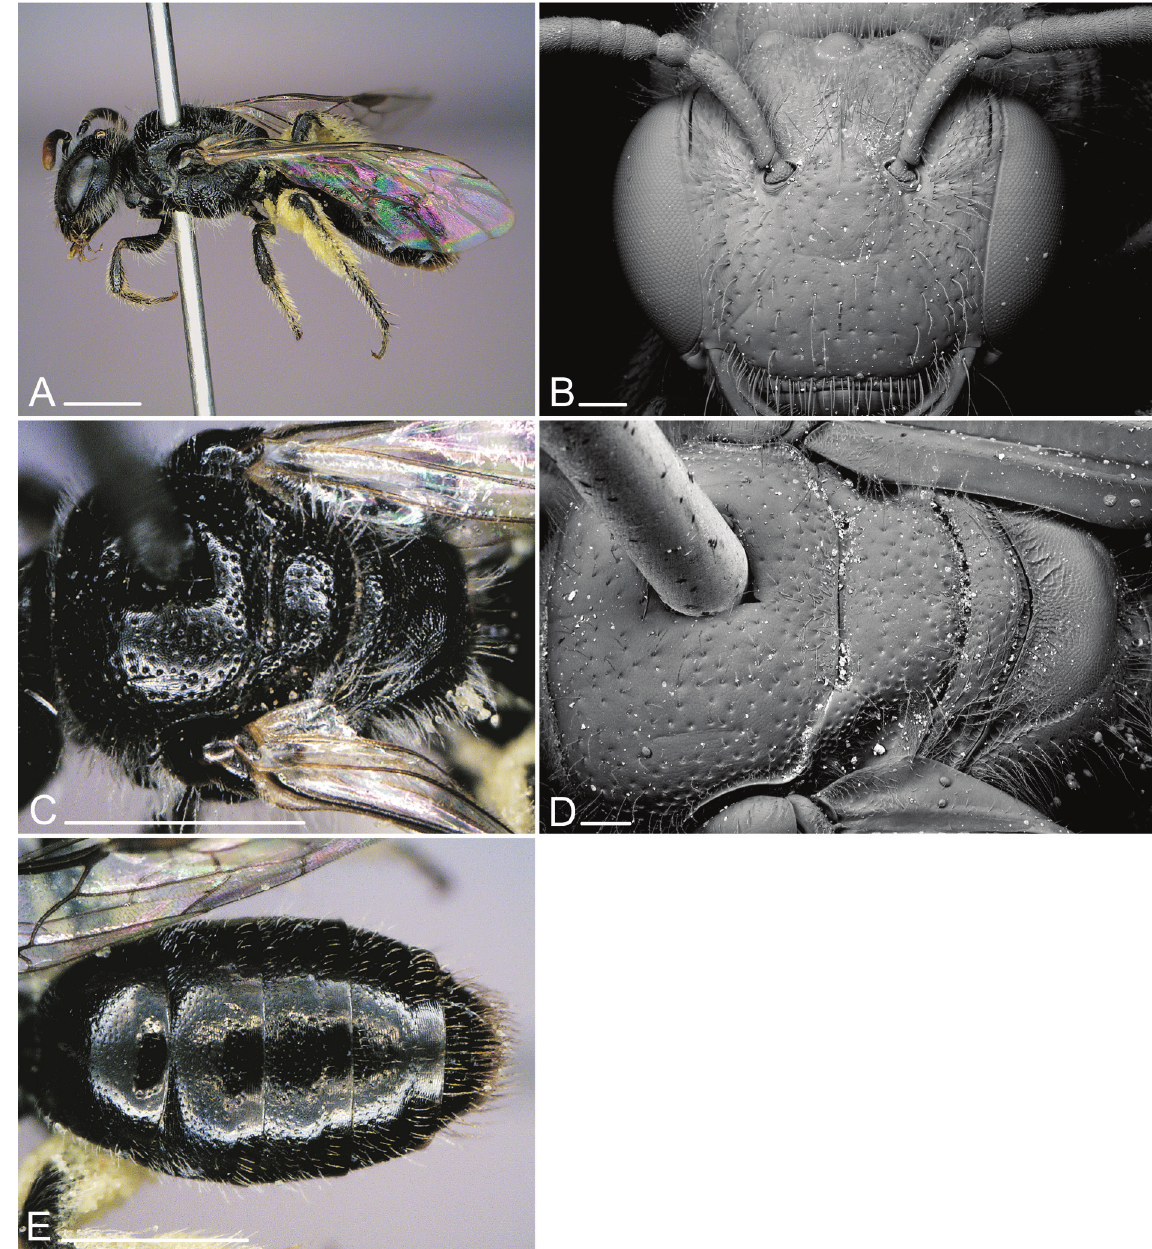
Fig. 30. Scrapter spinipes sp. nov., ♀. A . Lateral view. B . Head (SEM). C . Thorax (dorsal view). D . Thorax (dorsal view, SEM). E . Metasoma (dorsal view). Scale bars: photos: 1 mm, SEM: